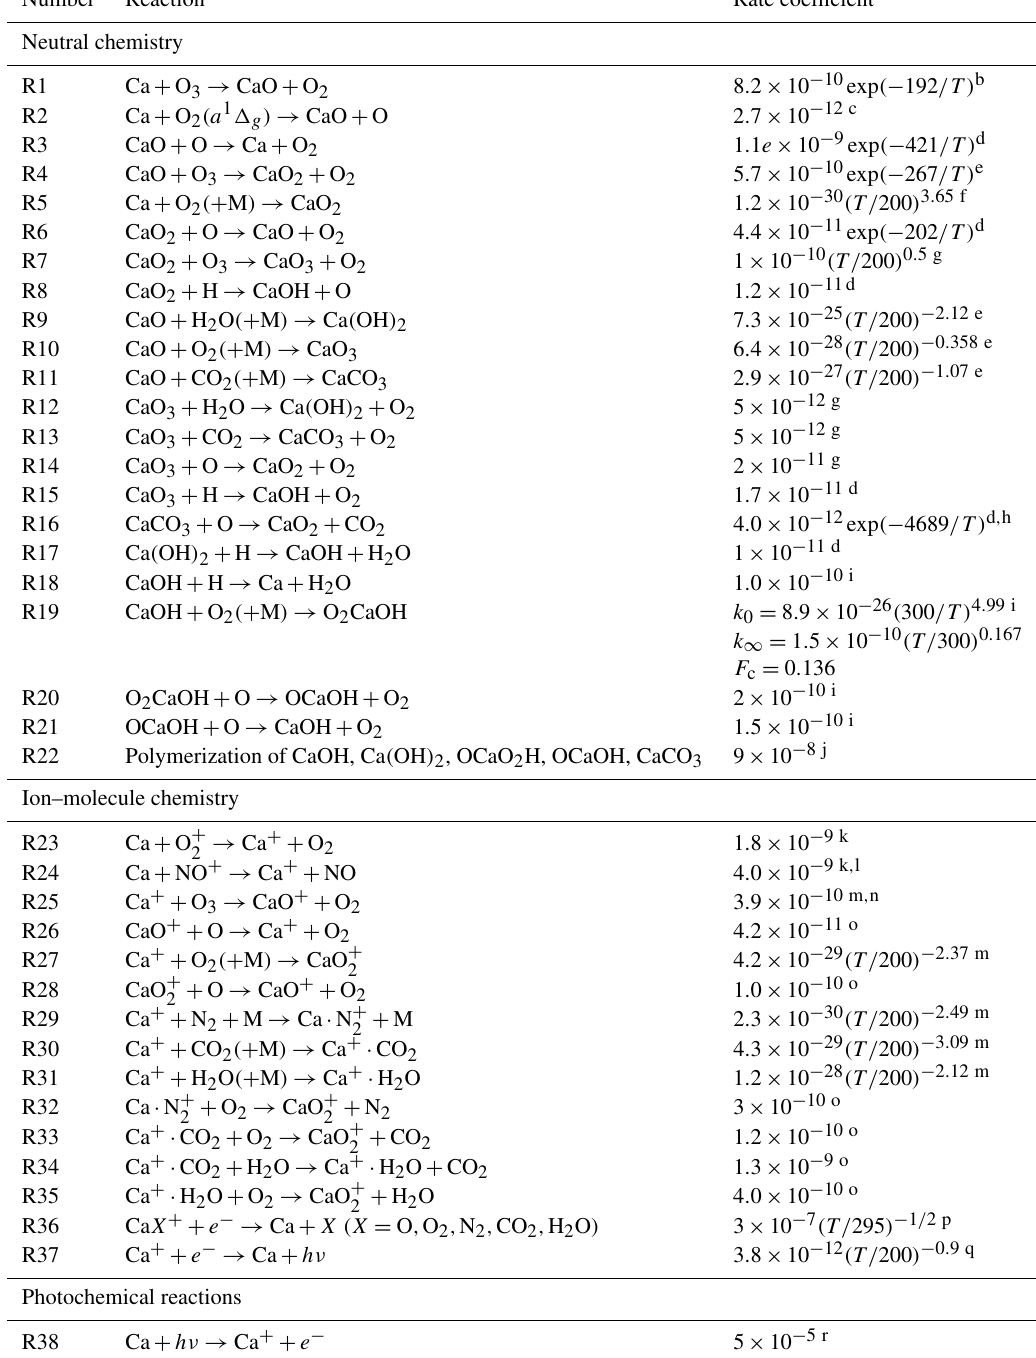
Table 1. Gas-phase neutral and ion–molecule reactions of Ca species. Number Reaction Rate coefficient a Neutral